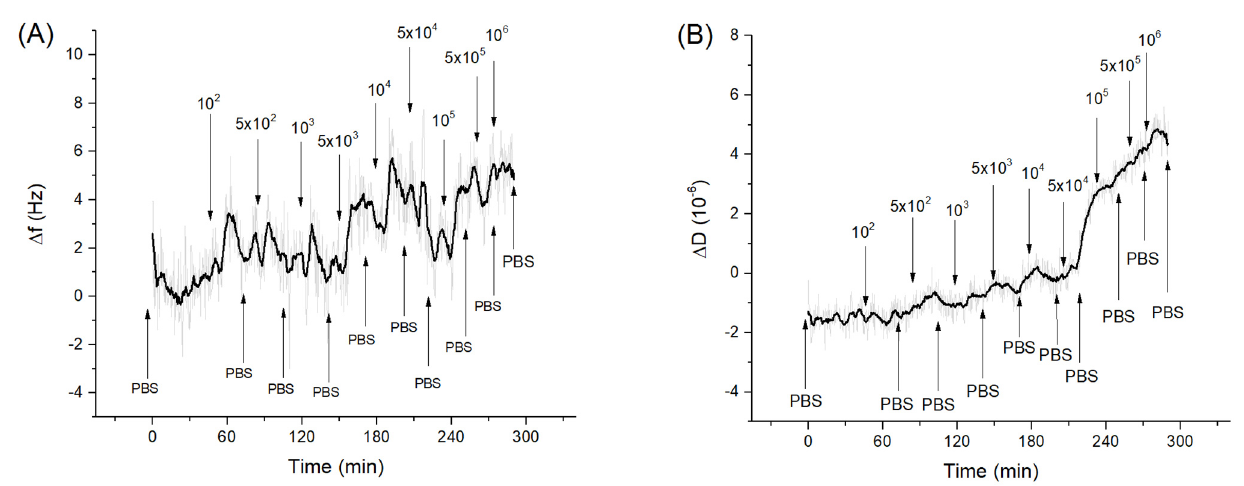
Figure 4. The kinetics of the changes of ( A ) fundamental frequency and ( B ) dissipation of the QCM transducer covered by neutravidin and aptamers specific to Listeria spp. following addition of E. coli in various concentrations (in CFU/mL). The moment of addition of bacteria as well as washing of the surface by PBS are shown by arrows.